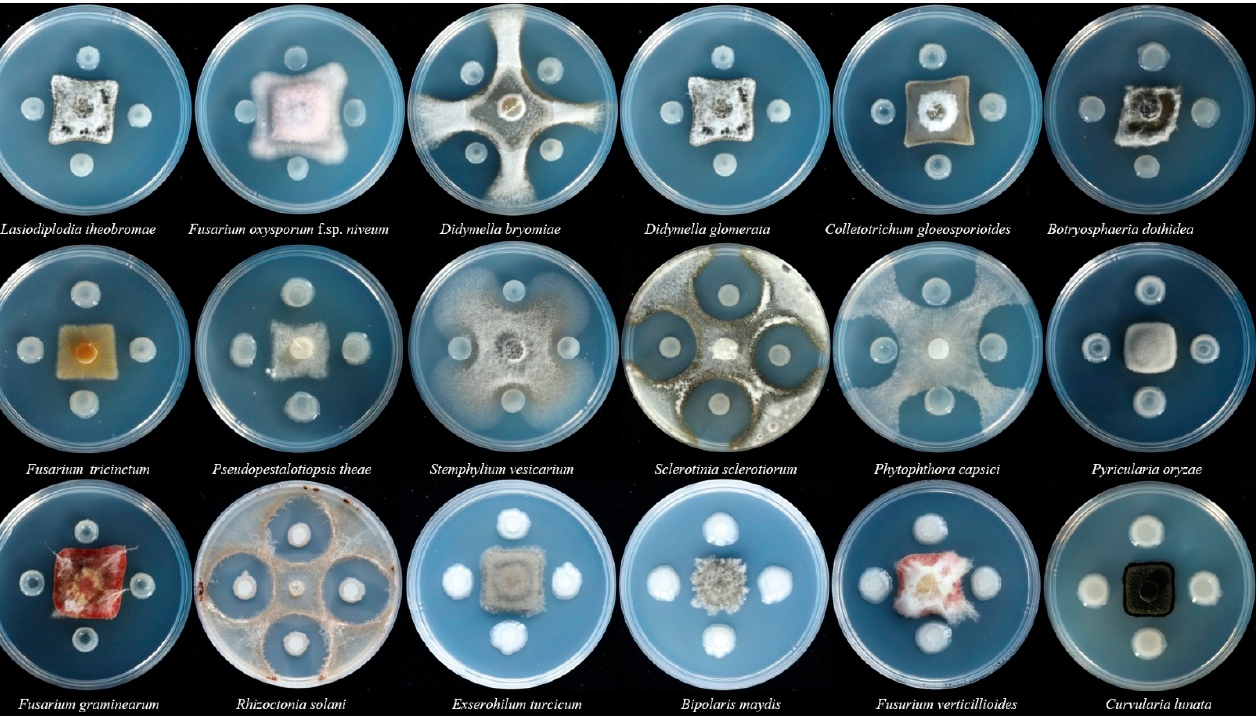
Figure 2. Antagonistic activities of P. polymyxa strain SF05 against pathogenic fungi. The antagonistic results were observed enough times after co-inoculation of P. polymyxa strain SF05 and pathogenic fungi on PSA plates and incubation at the temperature of 28 °C.